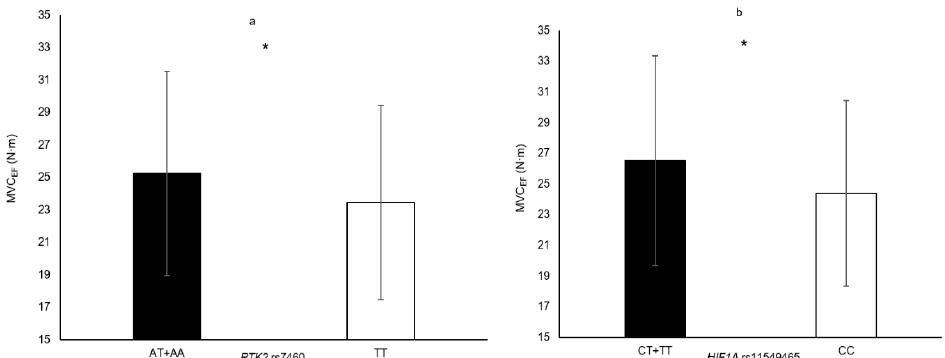
Figure 2. Isometric elbow flexion maximum voluntary contraction in genotype groups for ( a ) PTK2 rs7460 (TT = 71 vs. AT + AA = 233, Δ = 7.7%); ( b ) HIF1A rs11549465 (CT + TT = 63 vs. CC = 241, Δ = 8.7%). * denotes significant difference. Data are mean ± SD.